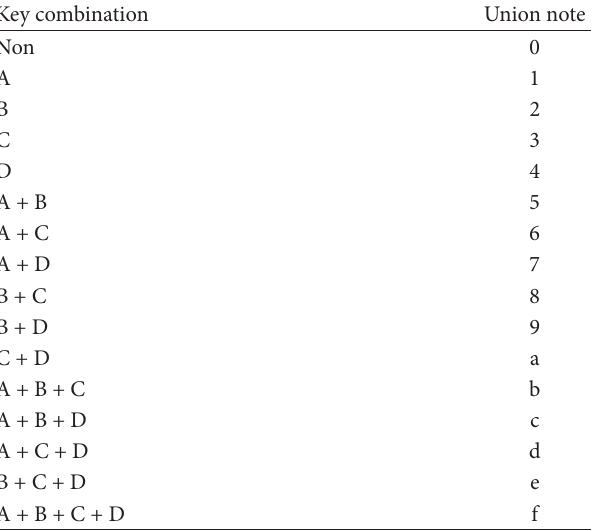
Table 3: Matching table for generation of union key. Key